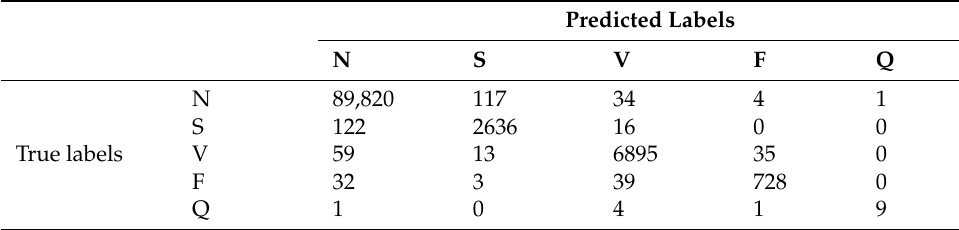
Table 4. Confusion matrix for the intra-patient paradigm.